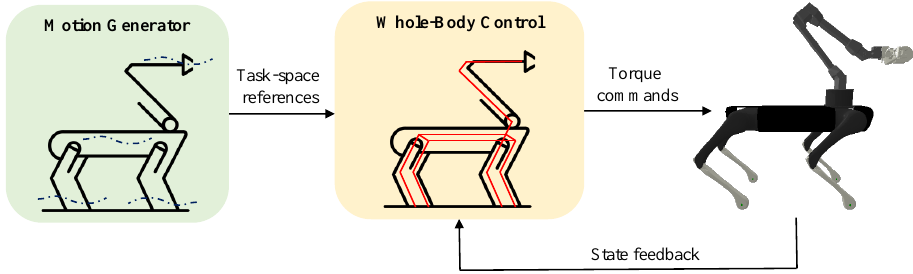
Figure 2. Control Structure. Cartesian motion planner plans the task–space reference trajectories sent to the proposed controllers. The controllers track planned references while satisfying physical feasibility